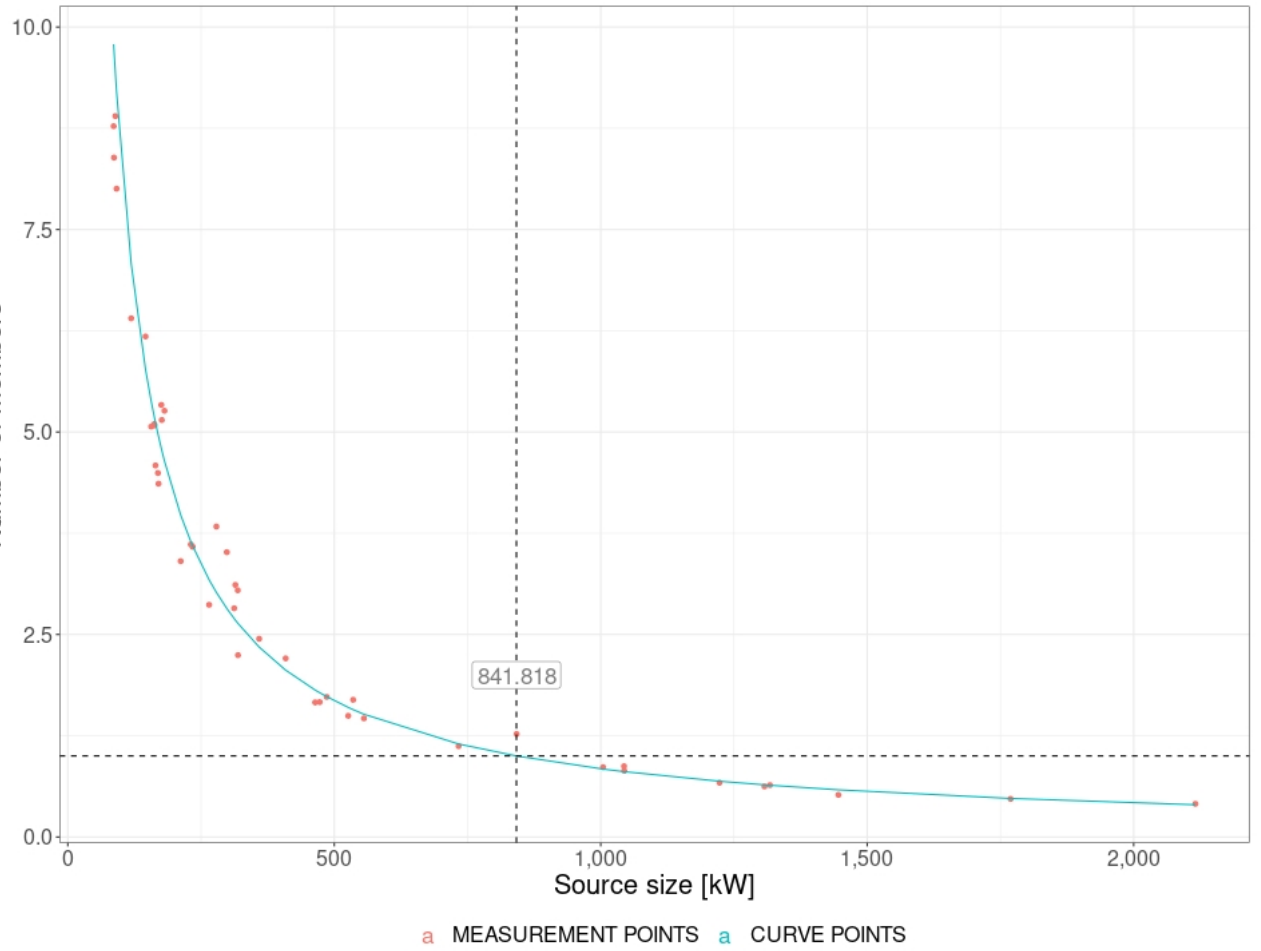
Figure 9. Curve representing the dependency of the number of members of cooperative with a wind source and 10% surplus energy for crypto-coin mining. The diagram marks the α coefficient of 841.818. It corresponds to the wind source capacity of 841.818 kW, which will cover the demand of the excavator and of a